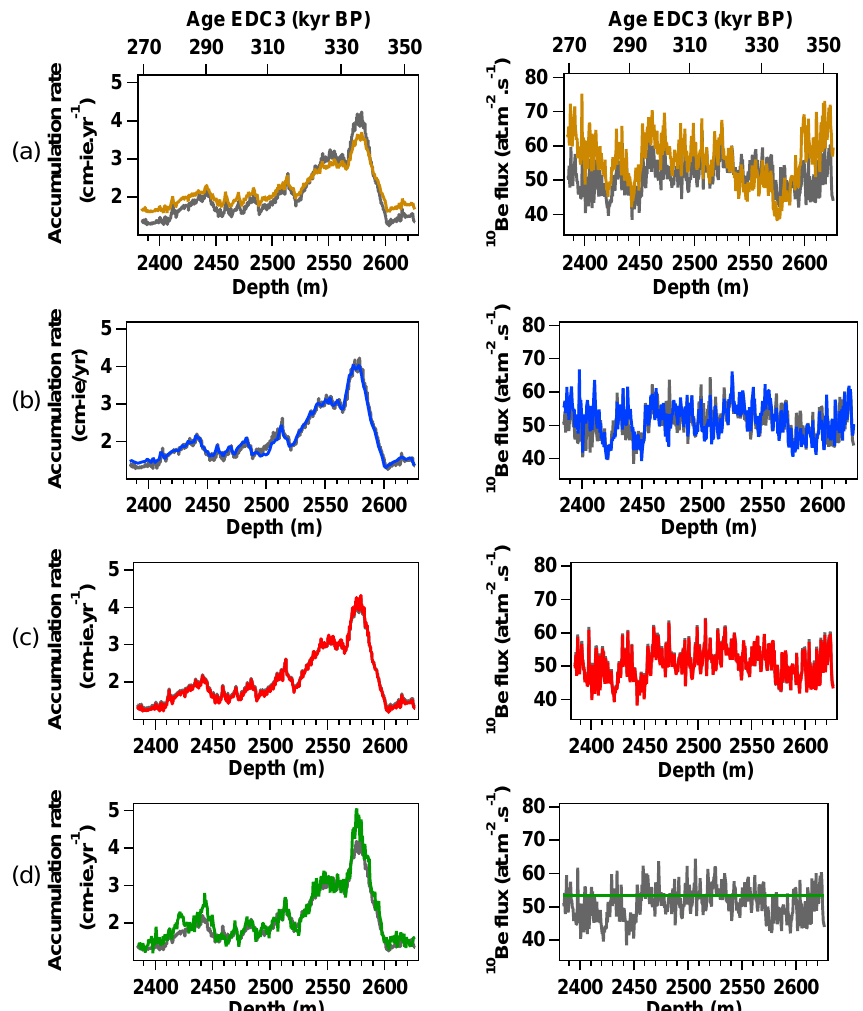
Figure 2. Several accumulation rate reconstructions (left column) and the corresponding 10 Be flux corrected by PISO-1500 (right column) discussed in Sect. 3 (coloured curves). The EDC3 reconstruction from Parrenin et al. (2007a, b) is shown in grey for comparison. (a) Satu- ration vapour pressure formulation. (b) Application of the AICC2012 chronology on the 10 Be record. (c) Optimization of the interglacial– glacial amplitude coefficient ( β ) by minimization of the variance of the 10 Be flux corrected for past variations in geomagnetic field intensity (red curves). (d) Accumulation rate assuming a constant 10 Be flux (fixed at 53.44atm − 2 s − 1 over the whole